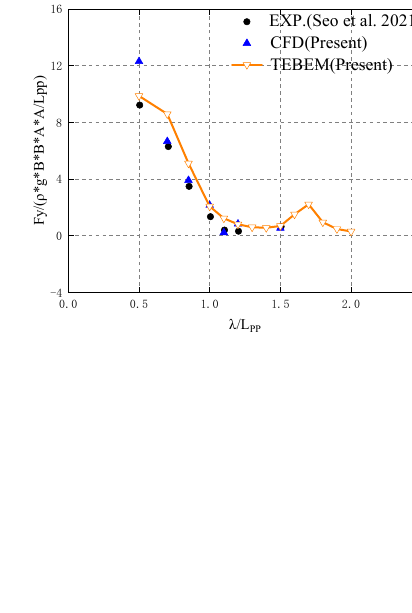
Figure 15. The surge, sway, and yaw wave drift forces and moment of KVLCC2 under H = 0.02 L PP , χ = 120°, β = 0°, and U = 6.0 kn.